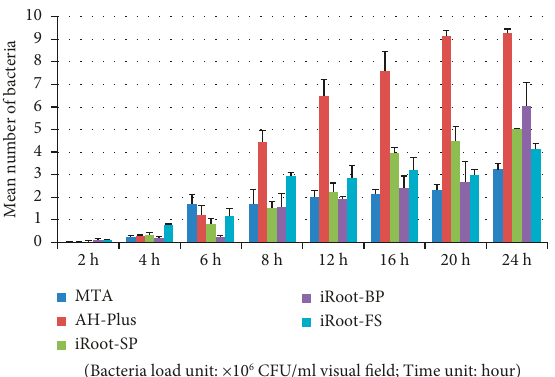
Figure 7: Porphyromonas gingivalis group (plate colony counting).